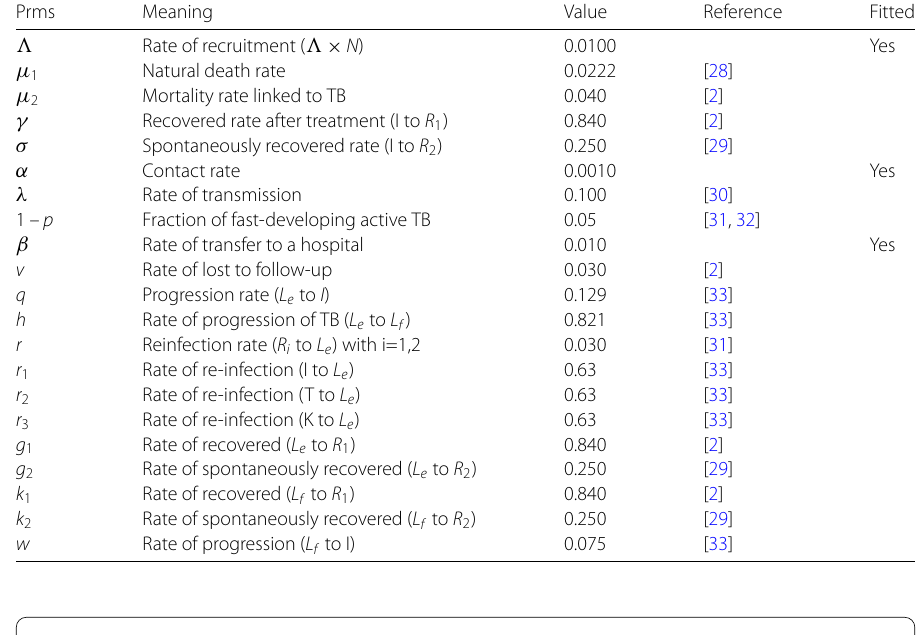
Table 1 Parameter values and their meanings